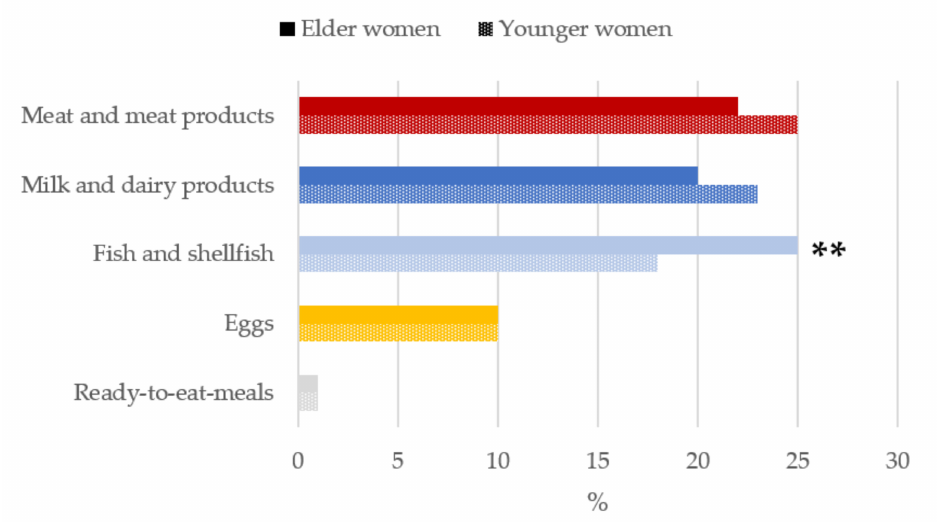
Figure 5. Contribution of main sources (food and beverages) to vitamin B 12 intake by age-group in women of childbearing age from the ANIBES study. ** p < 0.01 difference vs. younger women (Mann–Whitney’s U